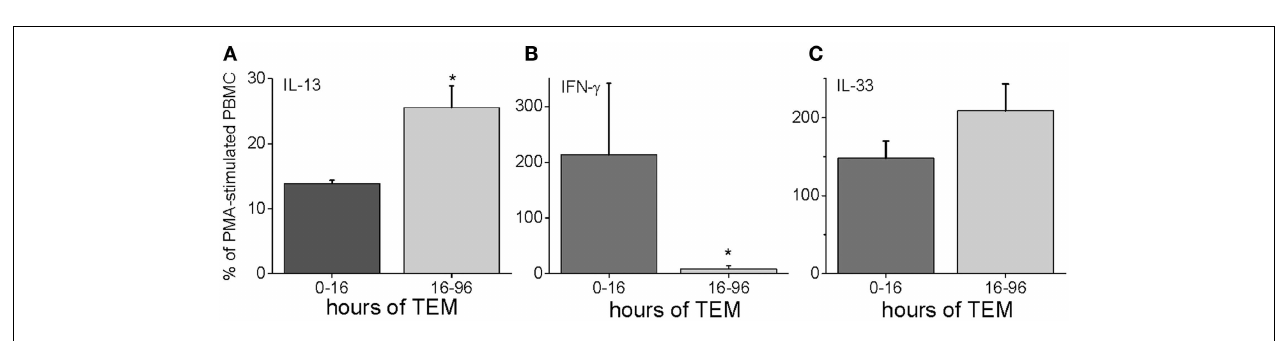
mitogen-expanded total PBMCs for IL-13 (A) , IFN- γ (B) , and IL-33 (C) ( n = 3 donors in duplicate, * p < 0.05 for the comparison of the indicated group from the total PBMC